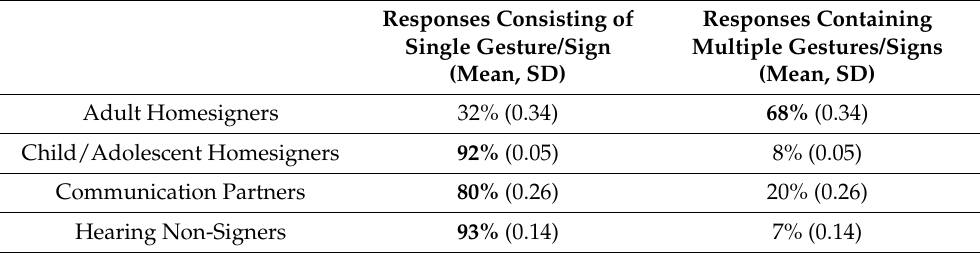
Table 3. Percentage of responses that were a single sign/gesture versus multiple signs/gestures for each group. Most common response type for each group is bolded.